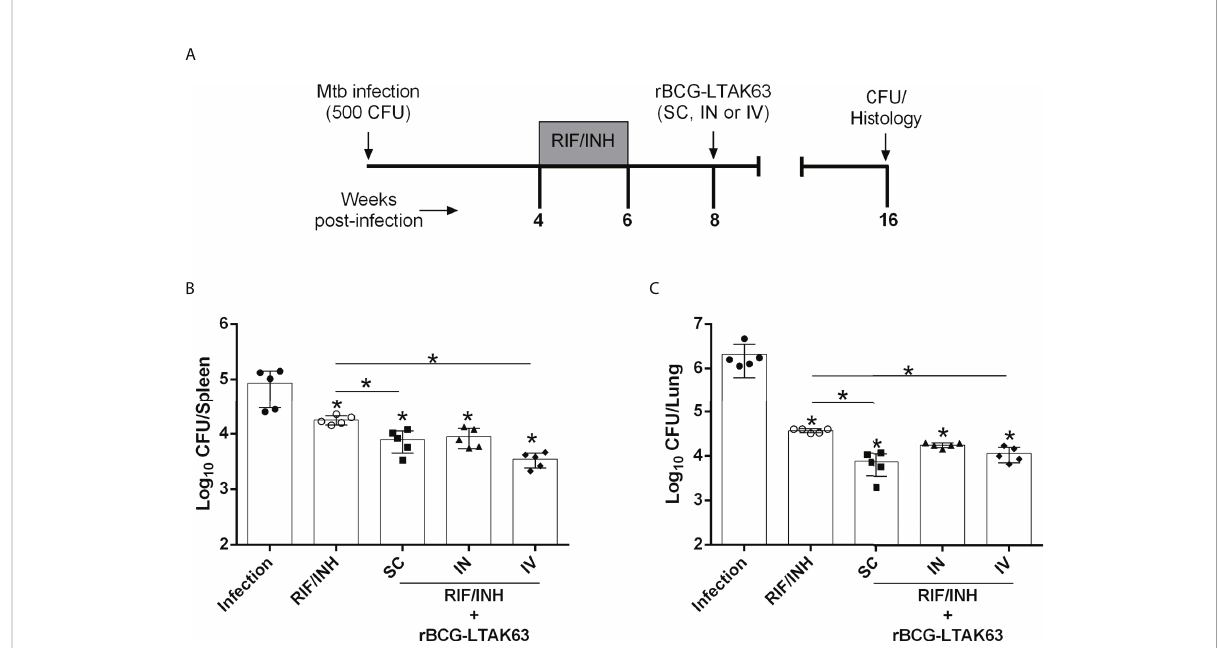
FIGURE 4 Combination of chemotherapy and rBCG-LTAK63 in the treatment of Mtb infection. (A) Schematical representation of the combination of chemotherapy with rBCG-LTAK63. BALB/c mice were infected with Mtb (500 CFU/IN) and treated 4 weeks later with rifampicin and isoniazid (RIF/INH) for 2 weeks. After two weeks interval rBCG-LTAK63 was given via SC, IN or IV routes. Eight weeks after treatment, the spleens and lungs of these animals were collected and homogenized. Serial dilutions were plated onto 7H10 agar plates containing TCH (a BCG growth inhibitor) to assess Mtb CFU. Bacillary load in the spleens (B) and lungs (C) of Mtb-infected mice treated with combination chemotherapy (RIF/ INH) and rBCG-LTAK63. Statistical differences were determined by one-way ANOVA with a Bonferroni test. * p values ≤ 0.05 were considered statistically signi fi cant. Asterisks over the columns refer to the comparison with the infection group. Results are represented by the means ± SD of the CFU recovered in the cranial and median lung lobes from the groups of mice